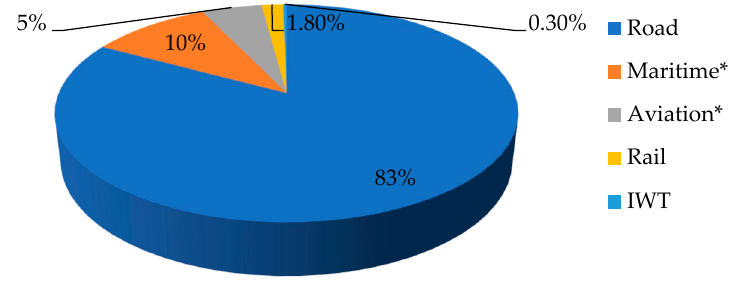
Figure 8. Share of the different modes on total external costs 2016 for EU28 [15].